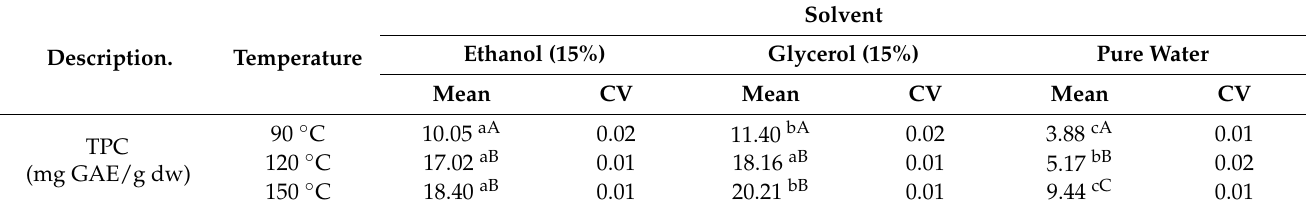
Table 1. Total polyphenol content of the extracts obtained by HPLE.